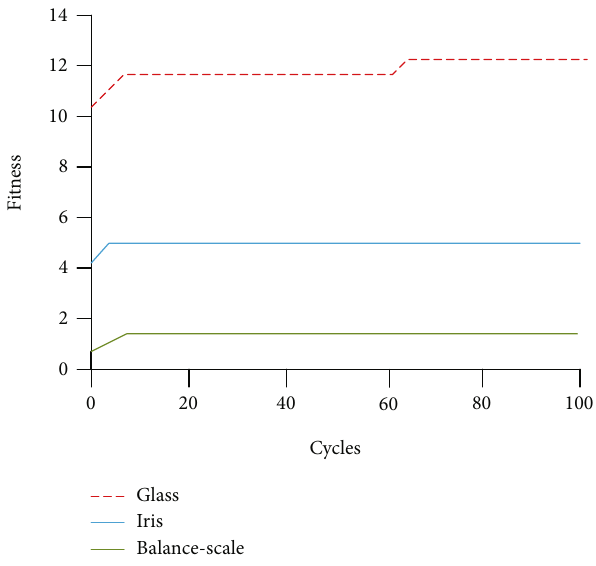
Figure 6: Convergence trend of fi tness values of improved bee colony K-means algorithm on three data